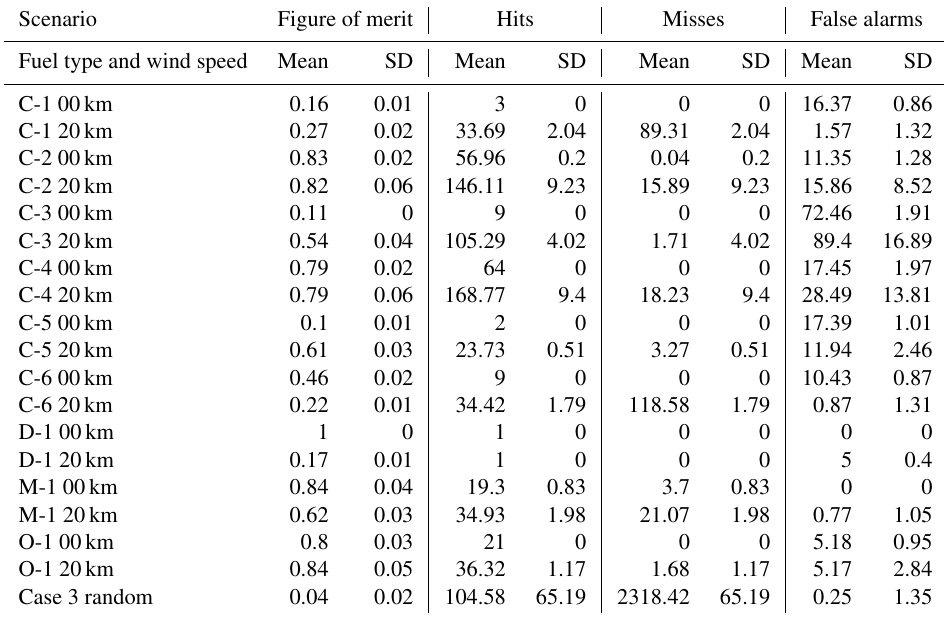
Table 3. Figure of merit values from ensemble simulations for different fuel types. Scenario Figure of merit Hits Misses False alarms Fuel type and wind